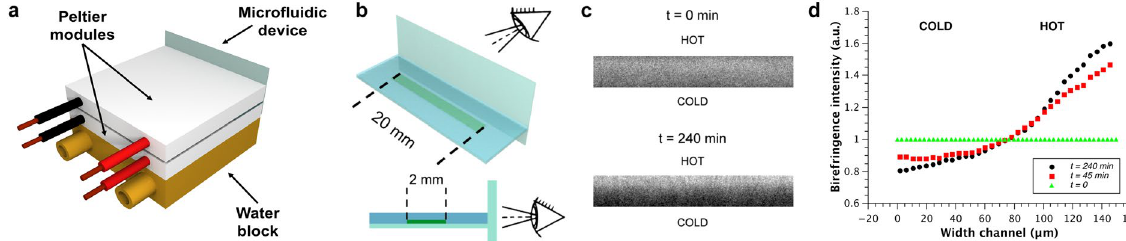
Figure 4. Direct observation of the I + N biphasic phase under microscopic polarized light. ( a ) Overall schematic of the cell used to record birefringence images and its temperature control through the use of two Peltier modules. ( b ) Enlargement of the microfluidic cell (not to scale). A thin glass cover slip placed perpendicular to the microfluidic cell permits optimized horizontal microscopic imaging under polarized light conditions; the thickness of the cell is 150 µ m. ( c ) Birefringence that provides evidence of the simultaneous I and N phase presence at steady-state (t = 240 min) compared to initial conditions (t = 0) at which only N is present. Static spurious contributions coming from the PDMS device have been removed by applying a bandpass filter via FFT to the images in panel c via FIJI software. Nonetheless, a background signal is still present as evidenced by the fact that we still detect a non-zero signal on the cold (I phase) side of the channel (see Fig. 4d and Fig. S4). ( d ) Time evolution of the normalised birefringent intensity profile across the microchannel: from a uniform birefringent profile an I to N continuous profile appears over